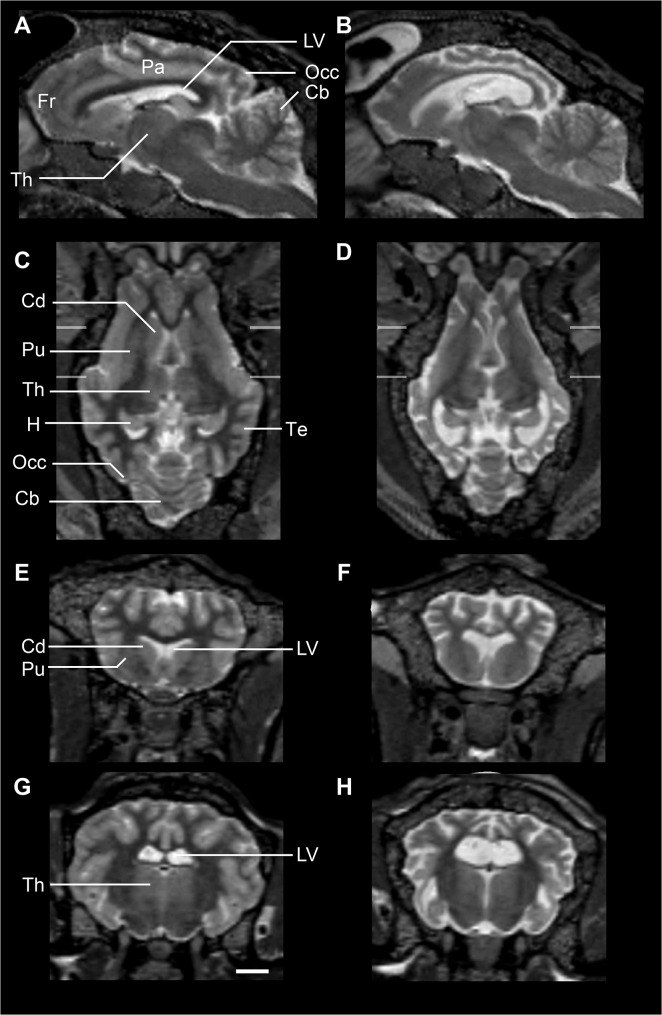
MRI of Batten disease and control sheep.MRI sections (T2) at baseline of a typical unaffected control (A, C, E, G) and a Batten disease affected sheep (B, D, F, H) in sagittal (A-B), horizontal (C-D) and coronal views at two different levels (E-H). Significant brain atrophy is evident in the affected sheep, particularly in the cortex, with concomitant enlargement of the ventricles. Scale bar is 1cm. Abbreviations: Fr frontal cortex, Th thalamus, Pa parietal cortex, LV lateral ventricles, Occ occipital cortex, Cb cerebellum, Cd caudate, Pu putamen, H hippocampus, Te temporal lobe.